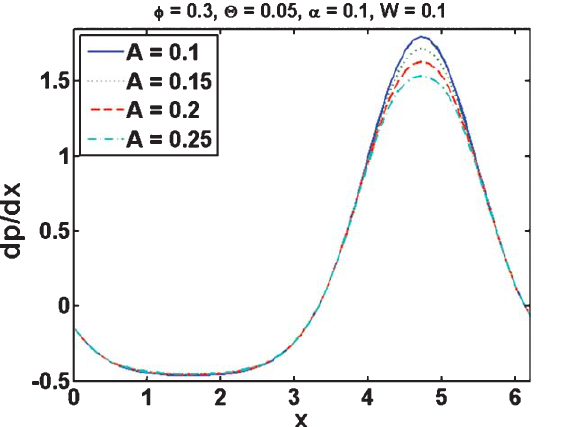
Fig. 13. Variation in dp/dx against x for different values of ampli- tude ratio ( φ ).